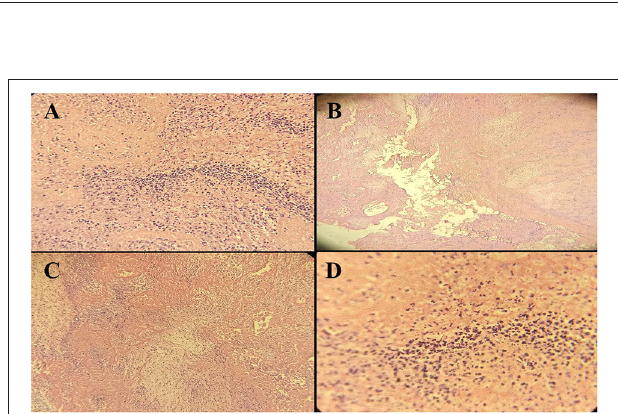
FIGURE 2 | Histopathological manifestations (40x resolution) of the posterior leaflet of mitral valve tissue in case 2 showing fibrinoid necrosis and cellular debris (A) , fibrinoid necrosis without evidence of bacterial colonization (B) , dense neutrophilic infiltration with cellular debris (C) , and necrotic area with neutrophilic debris induced by SARS-CoV-2 (D)